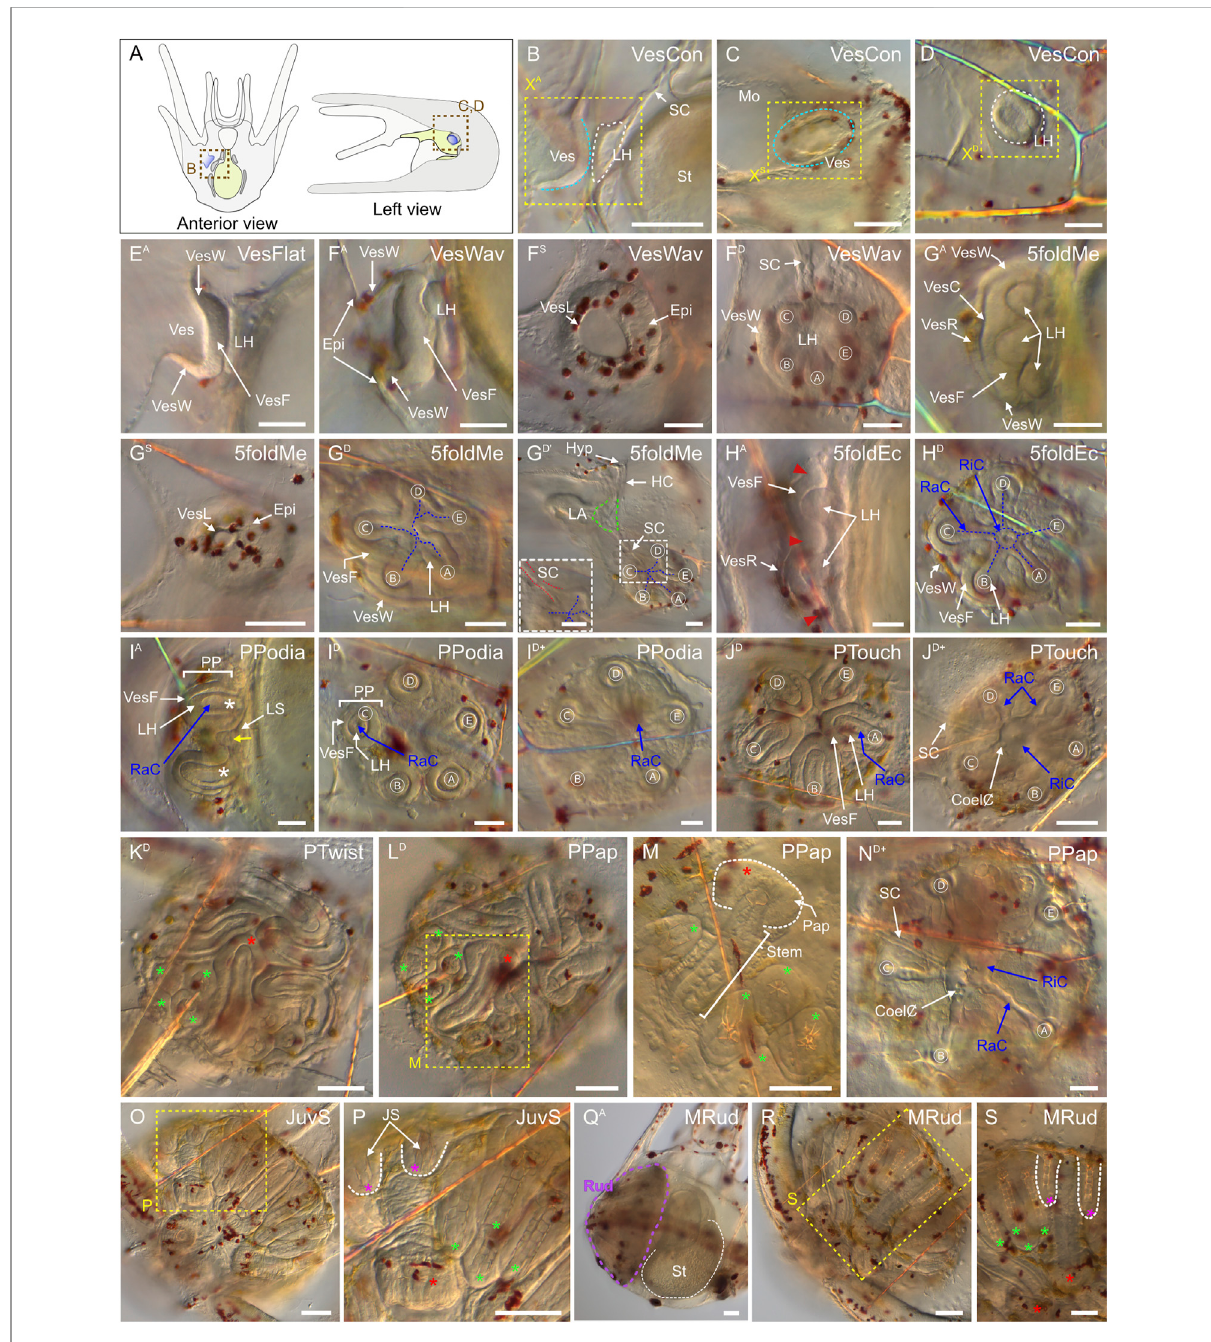
FIGURE 12 Paracentrotus lividus adult rudiment development under light microscopy. (A) Schematics of an 8-arm pluteus stage larva in anterior and left views. The vestibule (of ectodermal origin) is in blue and the larval coelomic pouch derivatives (of mesodermal origin) are in dark grey. Of note, although for simplicity we only represented an 8-arm pluteus larva, adult rudiment development actually takes place between the end of the 4-arm pluteus stage and the end of the 8-arm pluteus stage. In (B – S) , developmental stages are as follows: (B – D) vestibule contact stage (VesCon); (E A ) vestibule fl attened stage (VesFlat); (F A – F D ) vestibule waving stage (VesWav); (G A – G D ’ ) 5-fold mesoderm stage (5foldMe); (H A – H D ) 5-fold ectoderm stage (5foldEc); (I A – I D+ ) primary podia stage (PPodia); (J D – J D+ ) primary podia touching stage (PTouch); (K D ) primary podia twisting stage (PTwist); (L D – N D+ ) primary podia papilla stage (PPap); (O,P) juvenile spine stage (JuvS); (Q A – S) mature rudiment stage (MRud). In (B – S) , images were acquired using bright- fi eld light microscopy and correspond to close-ups of the developing or developed adult rudiment. (B – D) Close-ups of the regions highlighted by brown boxes in (A) . (E A – L D ,Q A ,N D+ ) Close-ups following the development of the regions outlined by yellow boxes in (B – D) , withpanels withsuperscriptlettersAcorresponding toregions X A ,with panelswithsuperscriptletters Scorrespondingtoregions X S ,andwithpanels with superscript letters D, D ’ or D+ corresponding to regions X D . (M) Close-up of the region marked by the yellow box in (L D ) , but at a different focal